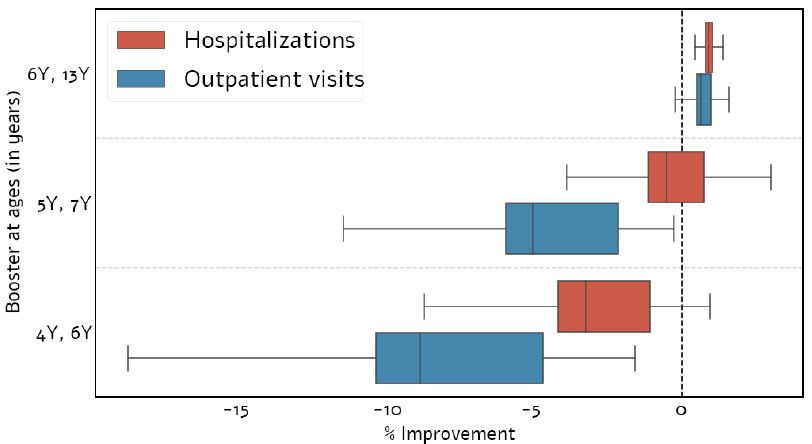
Figure 3. Effectiveness of different vaccination schedules for two booster doses. Effectiveness of different schedules in terms of reducing pertussis outpatient visits and hospitalizations for two booster doses as projected by our model. Effec- tiveness is reported as the percentage of improvement compared to the current vaccination schedule that targets children at the ages of 7 and 13.